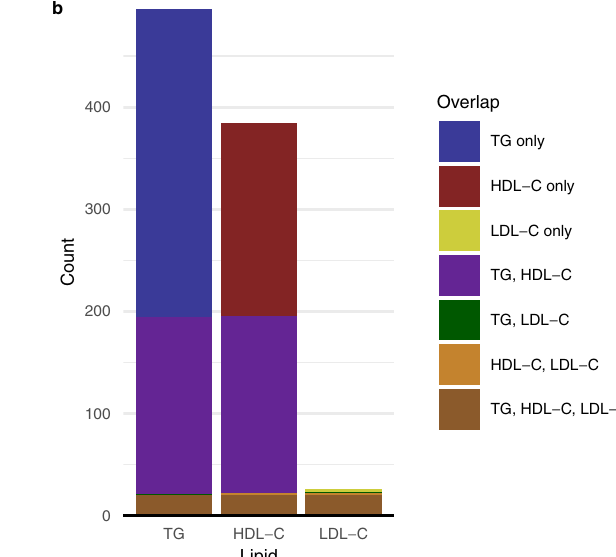
color represent genome-wide signi fi cant associations. The dashed horizontal line representstheBonferronithresholdbasedon17,740tests,i.e.thenumberofgenes. b Overlap between genes associated with lipid levels for TG, HDL-C, and LDL-C.